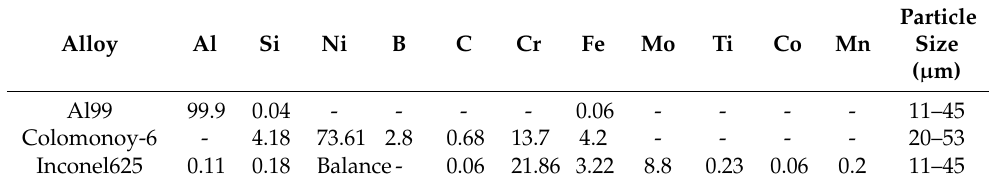
Table 1. The particle size of selected powders.